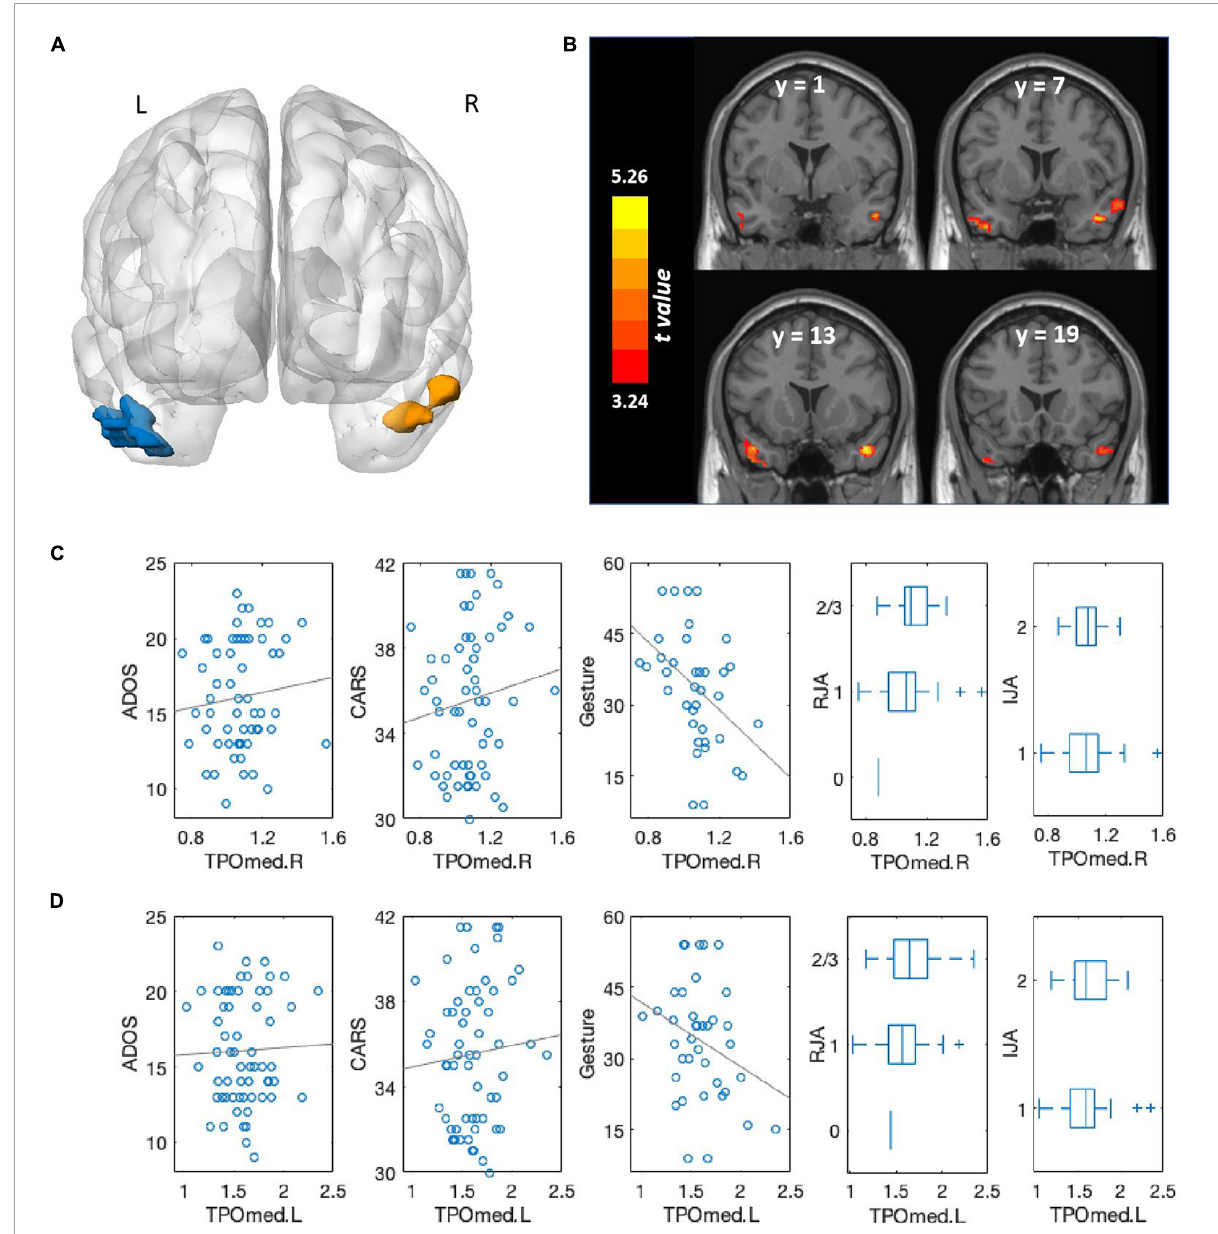
FIGURE2 Comparison of brain volumes between autism spectrum disorder (ASD) patients with and without developmental delay (DD) and associations with clinical symptoms. (A) Brain regions that significantly differed between ASD patients with and without DD. The blue region comprised the TPOmed.L and left inferior temporal gyri; the orange region primarily comprised the TPOmed.R. Multiple comparison corrections were p < 0.001 at the voxel level and p < 0.05 cluster-level family-wise error correction. (B) Brain regions that significantly differed between ASD patients with and without DD, shown in the coronal view. The color bar represents t -values. (C) Association between TPOmed.R volume and ADOS scores, CARS scores, gestures scores, RJA ability, and IJA ability across the whole group. (D) Association between TPOmed.L volume and ADOS scores, CARS scores, gestures scores, RJA ability, and IJA ability across the whole